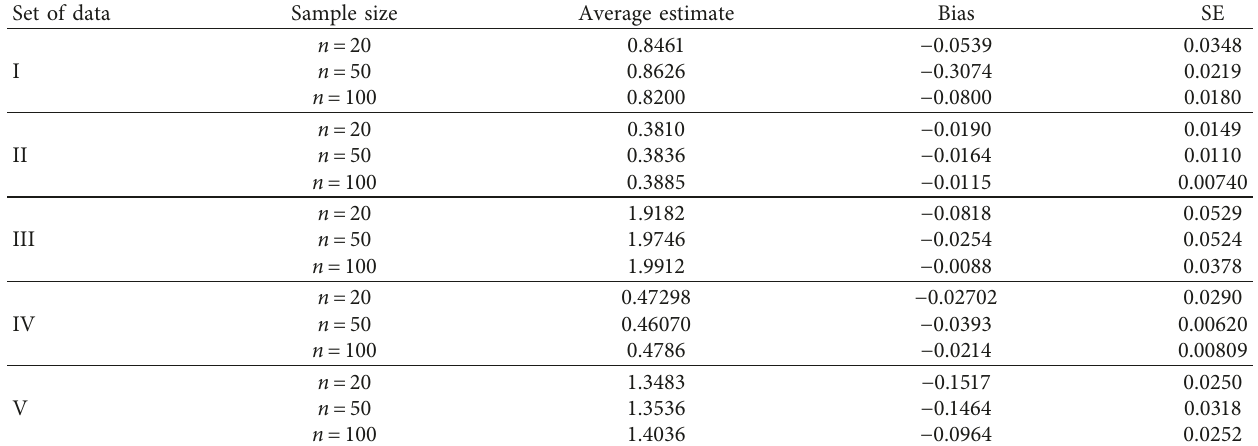
Table 1: The average estimates for the parameter θ , for sets of data I, II, and III, with bias and standard error. Set of data